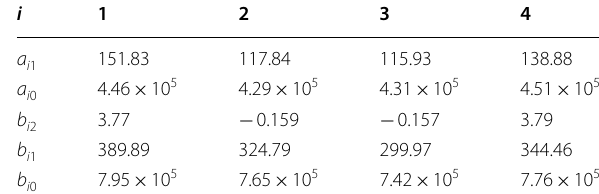
Table 3 Coefficients of modified transfer functions